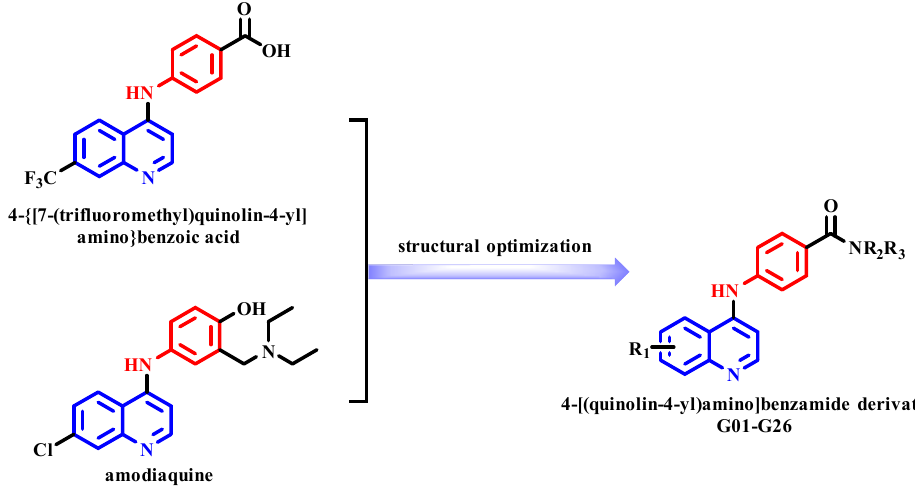
Figure 2. Design of 4-[(quinolin-4-yl)amino]benzamide derivatives ( G01 – G26 ).